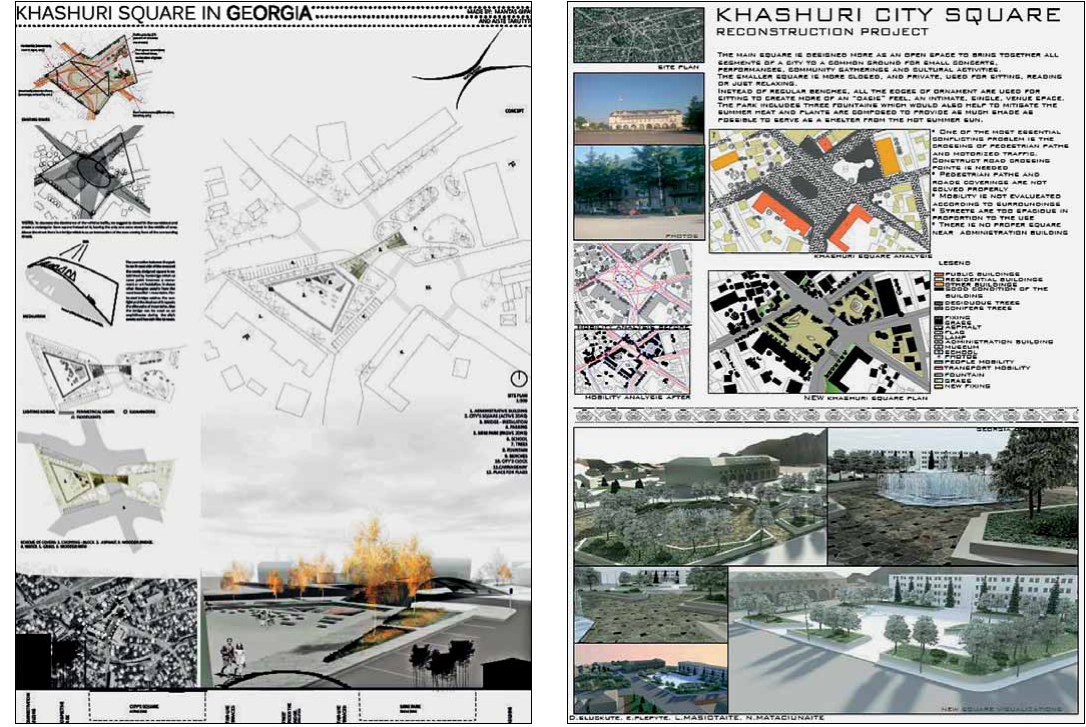
fig. 5. Proposals for the reconstruction of Khashuri square in Georgia